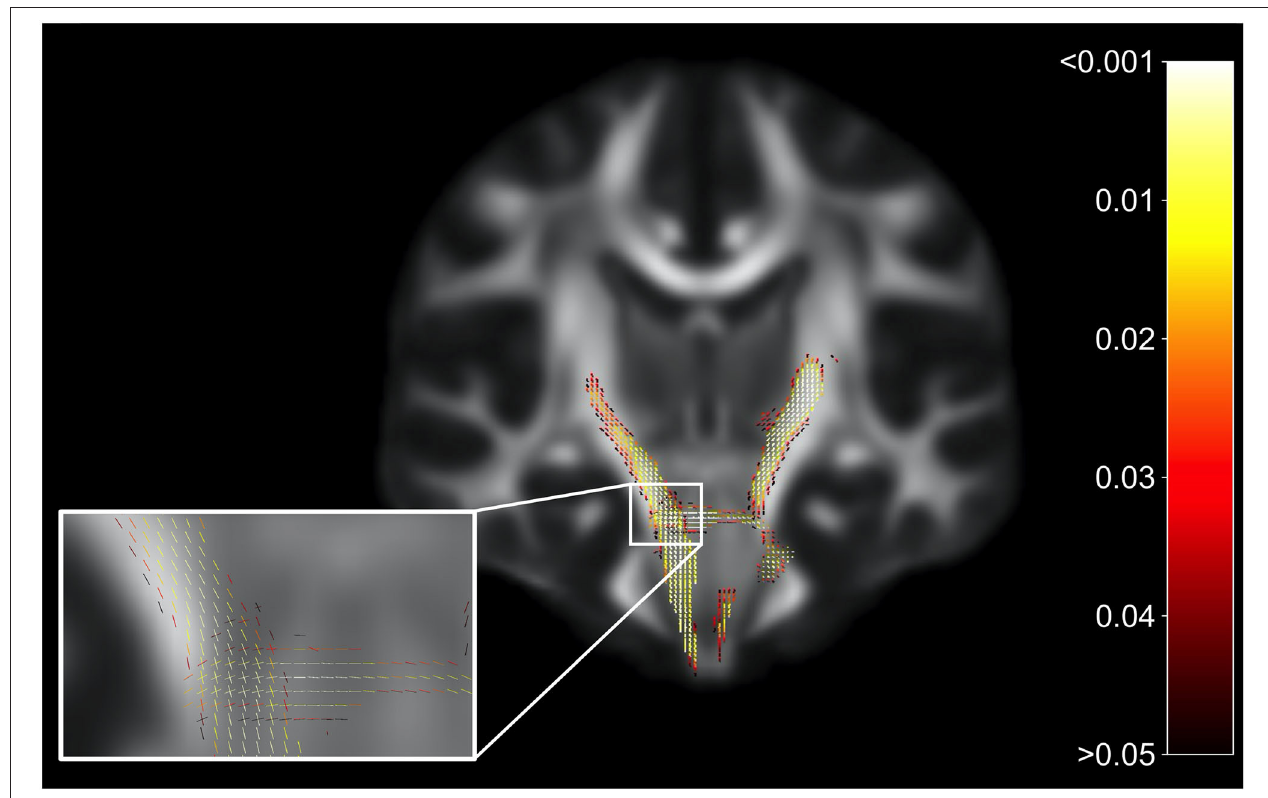
FIGURE 3 | Fiber tract-specific significant fixels. Coronal slice showing fixels that were significantly decreased (FWE-corrected p -values) in HIV + individuals compared to HIV–. The zoomed-in area illustrates differences and p -values assigned to individual fixels in regions with crossing-fibers, around the cerebral peduncles (CP) and middle cerebellar peduncles (MCP). Fixels are colored by FWE-corrected p